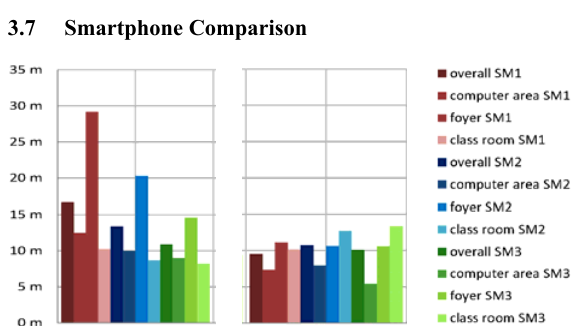
Figure 7. Comparison of the maximum deviations of the position estimates using the one-slope (left) and the differential approach (right) for three different smartphones SM1 to SM3 for static positioning